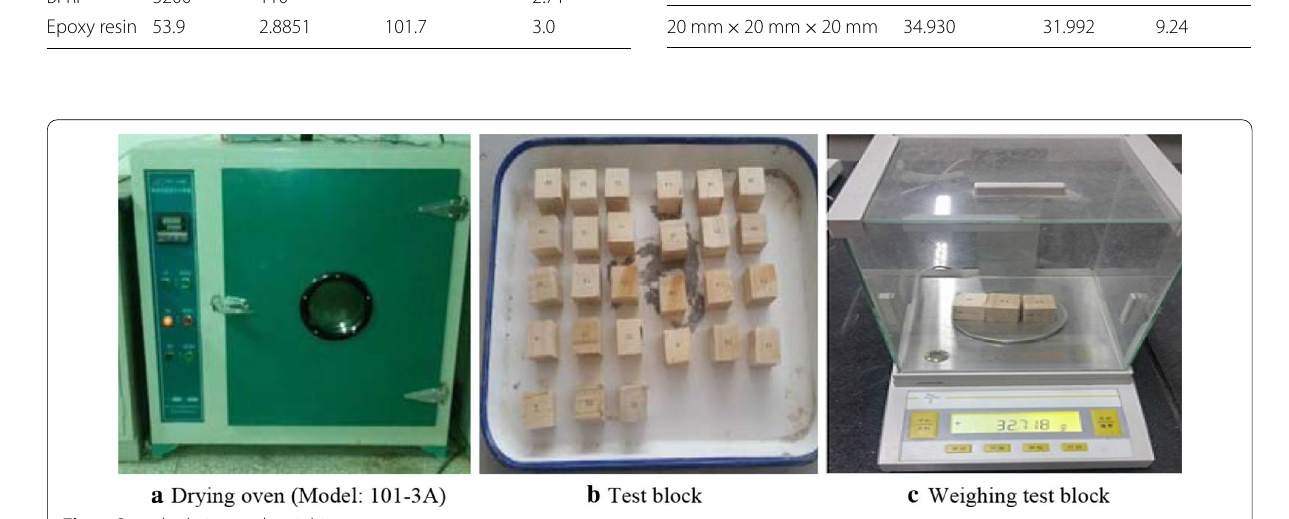
Fig.1 Sample drying and weighing process